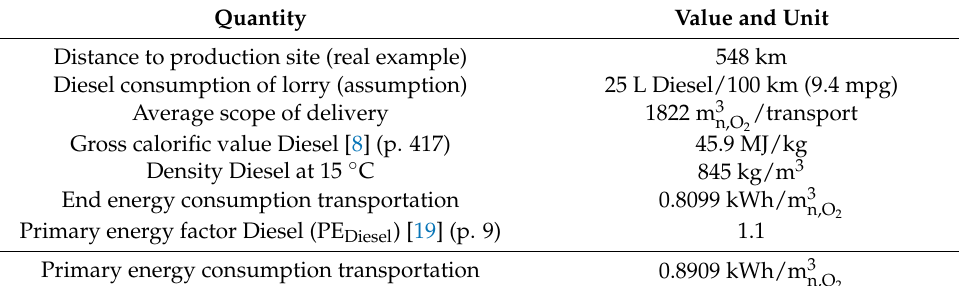
Table 4. Relevant values of the transport of liquid oxygen to the hospital. Quantity Value and Unit Distance to production site (real example) 548 km Diesel consumption of lorry (assumption) 25 L Diesel/100 km (9.4 mpg) Average scope of delivery 1822 m 3 /transport n,O 2 Gross calorific value Diesel [8] (p. 417) 45.9 MJ/kg Density Diesel at 15 ◦ C 845 kg/m 3 End energy consumption transportation 0.8099 kWh/m 3 n,O 2 Primary energy factor Diesel (PE Diesel ) [19] (p. 9) 1.1 Primary energy consumption transportation 0.8909 kWh/m 3 n,O